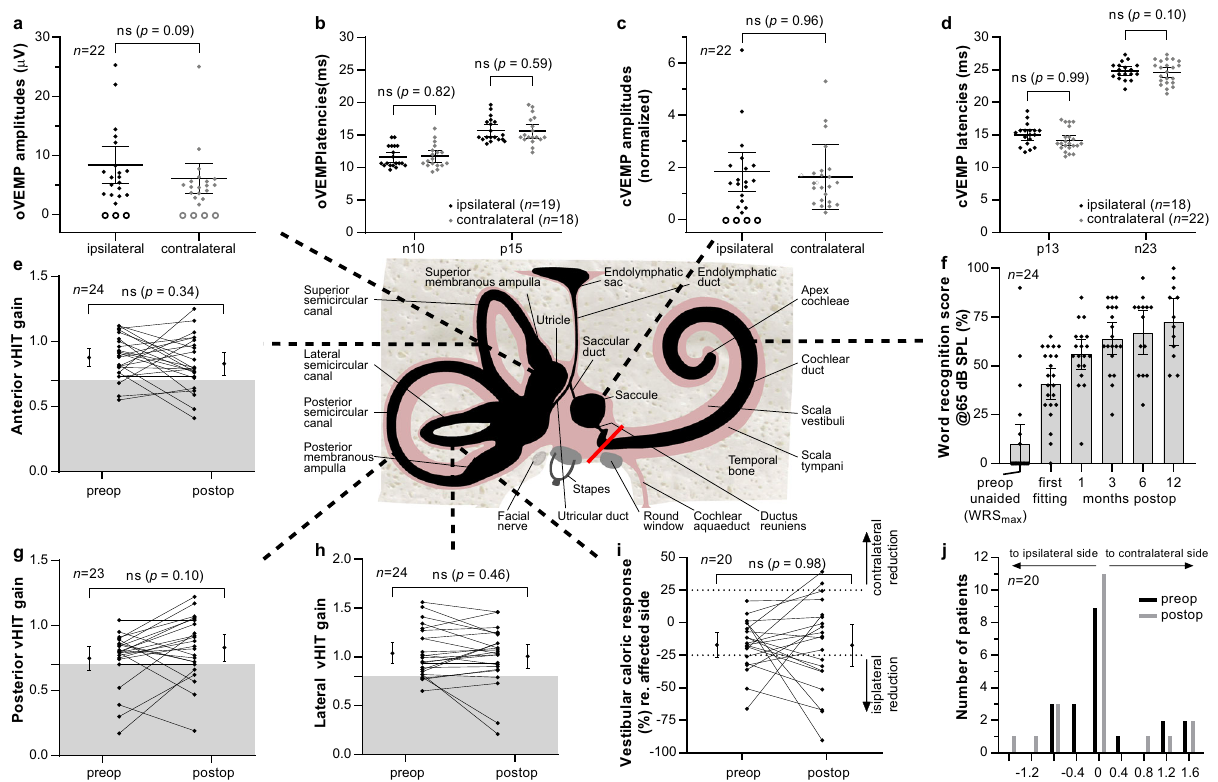
Fig. 2 Schematic illustration of the inner ear with the fi ve vestibular receptors and the cochlea and results of functional tests before and after surgery. Postoperative otolith receptor function amplitudes and latencies are shown for utricle ( a , b ) and saccule ( c , d ) with data points for individual patients, means and 95% con fi dence intervals. Pre- and postoperative impulse responses of the anterior and posterior semicircular canals (vHIT) are shown on ( e ) and ( g ) with each line showing the data for one patient. The means and 95% con fi dence intervals are shown adjacent to the data points. The gray areas in the vHIT plots show abnormal results. Fast frequency (vHIT) and low-frequency (caloric) response of the lateral semicircular canal ( h , i ) and spontaneous nystagmus ( j ) are shown. ‘ Ipsilateral ’ refers to the tumor-affected side and ‘ contralateral ’ to the other (healthy) side. Word recognition scores (WRS) for monosyllables at 65 dB SPL with the cochlear implant compared to maximum word recognitions scores before surgery (WRS max ) are shown on ( f ). The location of the surgical blockage of the vestibular from the auditory system is indicated as a red bar. All statistical comparisons were made with paired two- tailed t-tests. Error bars in ( a – i ) show the 95% con fi dence interval. n number of participants, ns not signi fi cant, preop preoperative measurements, postop postoperative measurements, SPL: sound pressure level, VEMP cervical (c) or ocular (o) vestibular-evoked myogenic potentials. vHIT video head impulse test. Schematic illustration adapted from Spalteholz 1920 34